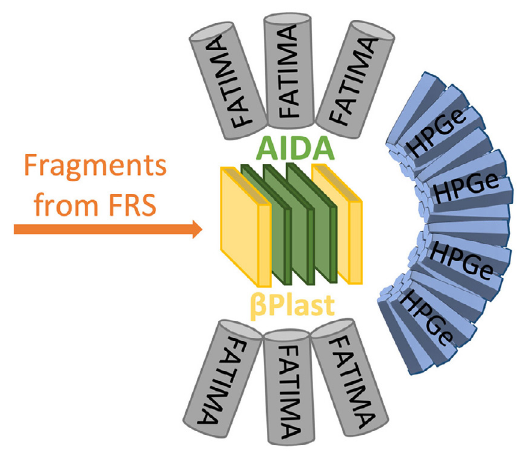
Fig. 3. – Schematic of the DESPEC decay